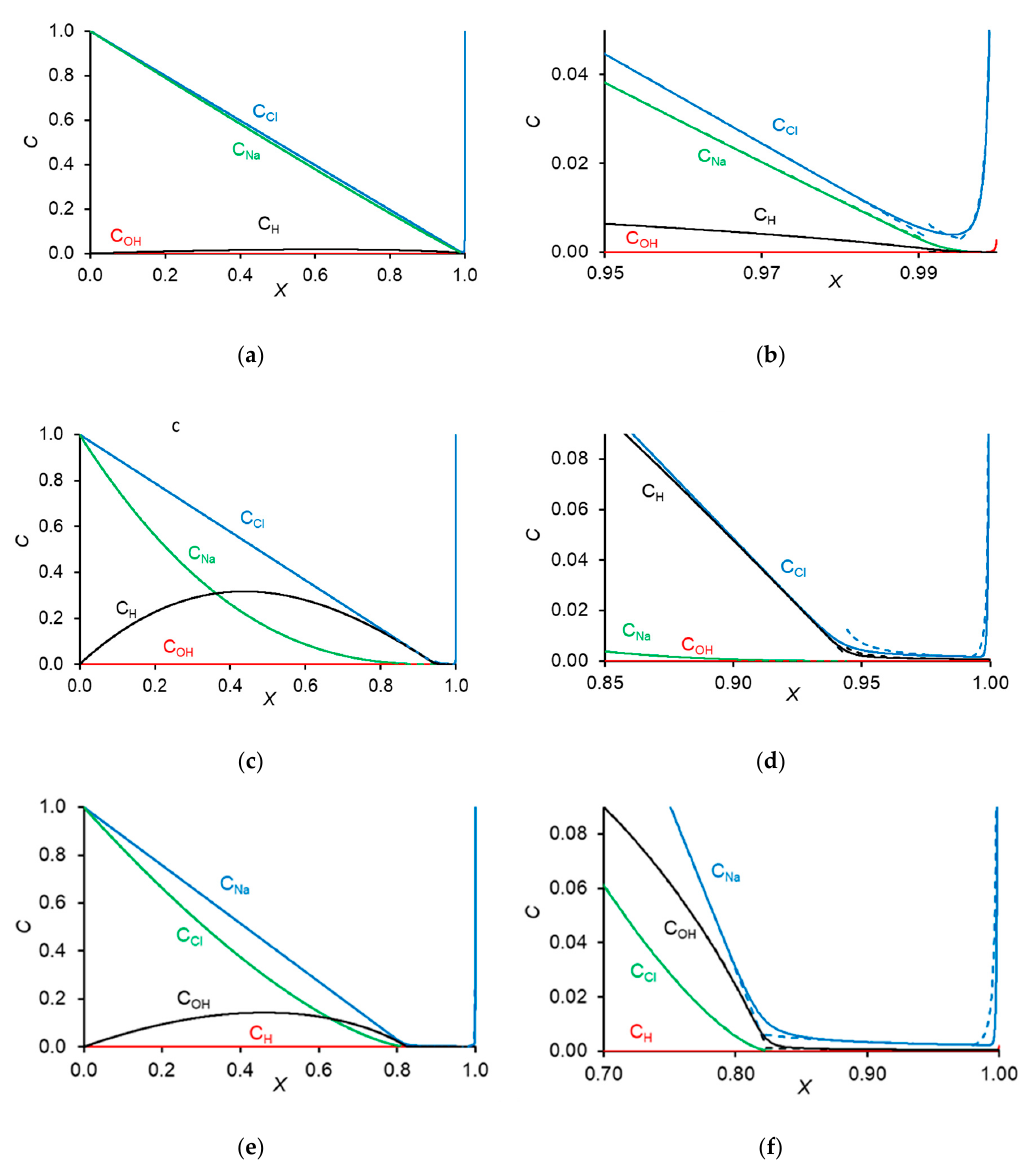
Figure 3. Concentration profiles of Na + , Cl − , H + , and OH − ions in the depleted DBL near the AEM ( a , b , c , d ) and CEM ( e , f ) shown at different scales, at current densities I = 1.8 mA cm − 2 ( a , b ) and I = 9.5 mA cm − 2 ( c,d,e,f ). Solid and dashed lines were calculated numerically and analytically, respectively. X = 0 relates to the bulk solution, x = 1, to the membrane surface.